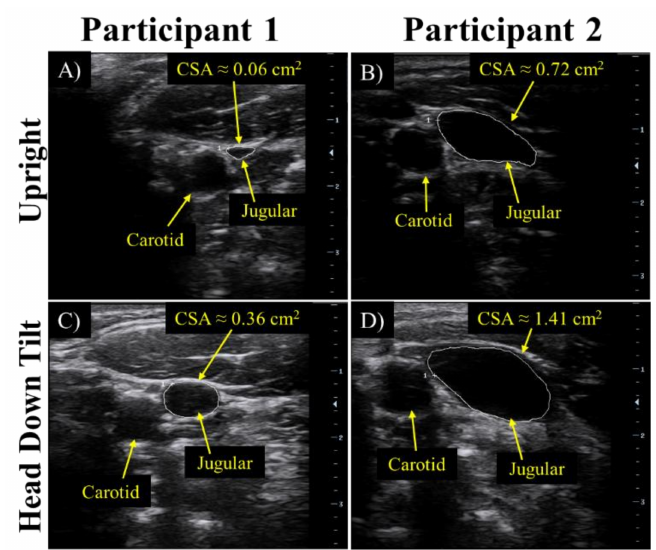
Figure 7. For the 70 s head down tilt at 50 ◦ , validation of the cephalad bio-fluid shift was determined by the cross-sectional area data obtained from ultrasound of the jugular vein as seen in upright position for